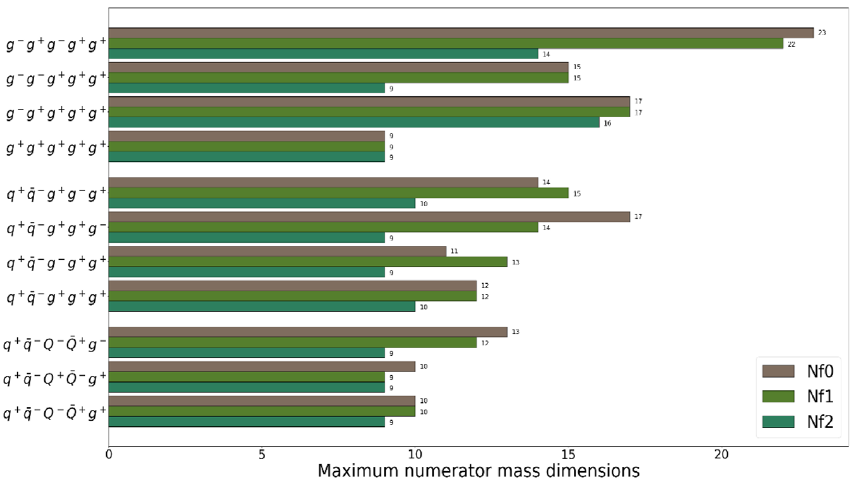
Figure 3 . Maximum mass dimension of the numerator ansatze. This can be equivalently thought of as the maximum degree of the polynomials in the angle and square spinor brackets. The ‘Nf’ labels refer to the respective terms in the expansion of eq.